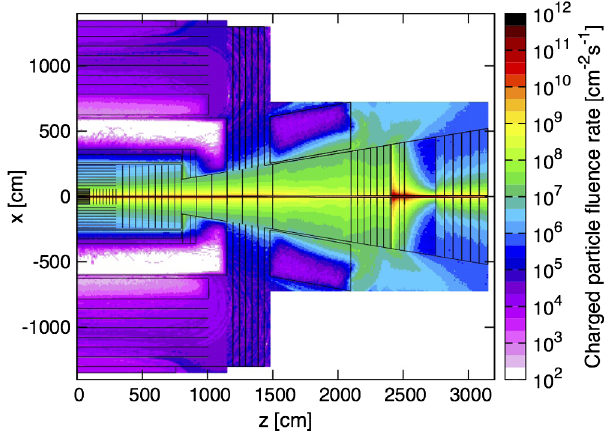
FIG. 5. Charged particle fluence rate for an instantaneous luminosity of 30 × 10 34 cm − 2 s − 1 : top view. In the central region ( z < 10 . 5 m) values are azimuthally averaged over 40 degrees around 0 (positive x ) and π (negative x ). In the forward region an average in the vertical direction around y ¼ 0 is done on a bin of 1 cm up to j x j ¼ 0 . 6 m and on a 10 cm bin for larger j x j values. The origin of the coordinate system corresponds to the nominal collision point.